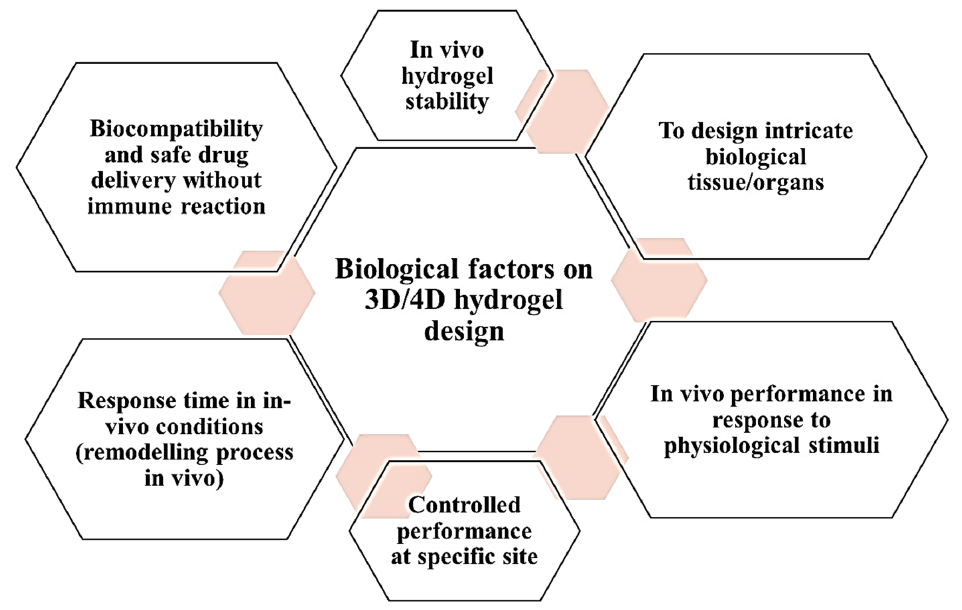
Figure 5. Biological factors responsible for controlling in vivo performance and other factors for 3D-/4D-bioprinted hy- drogel-based scaffold/construct/design.